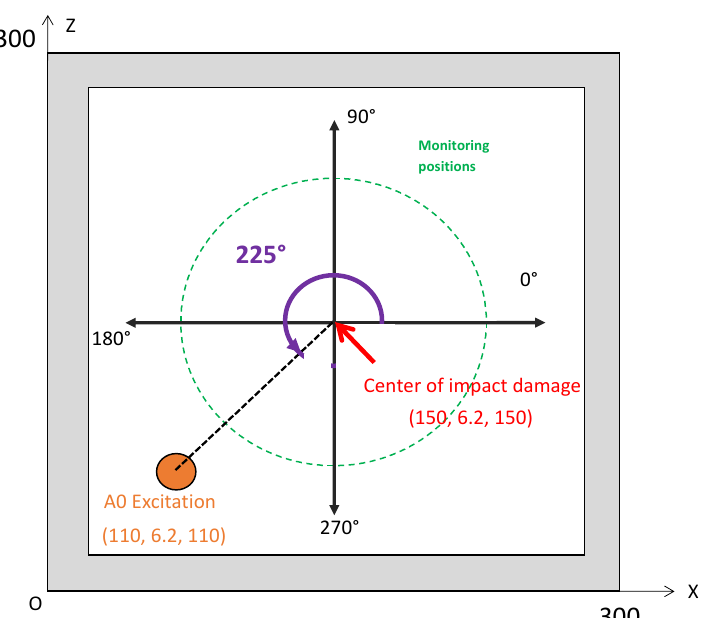
Figure 6. Schematic of the considered positions of excitation and reception in the model and experiments.